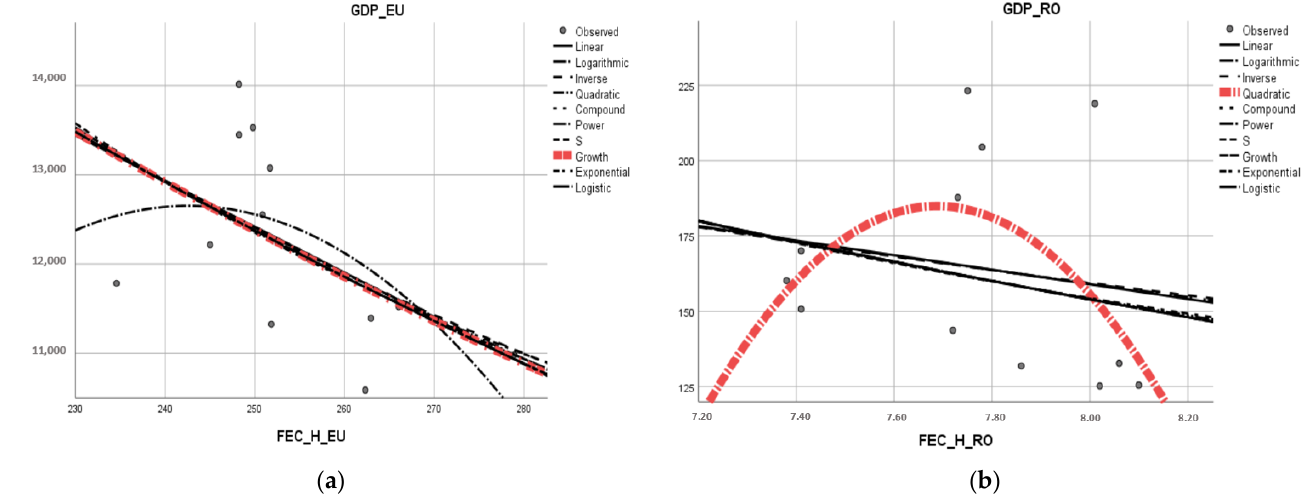
Figure 12. MLP network for identifying the influences of FEC_H on GDP: ( a ) EU; ( b ) RO.